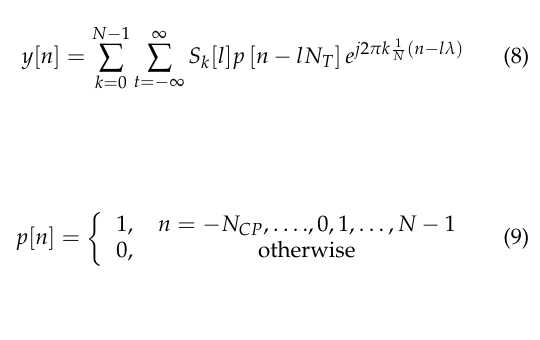
raised rectangular pulse shape cosine function (resulting in higher efficiency) (Eq. (10)), which is used in the work